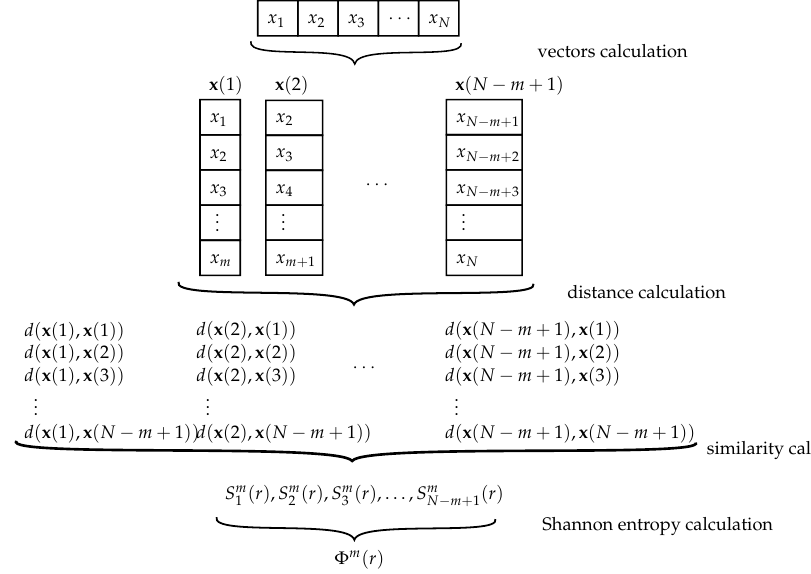
Figure 3. Diagram of the algorithm of approximate entropy